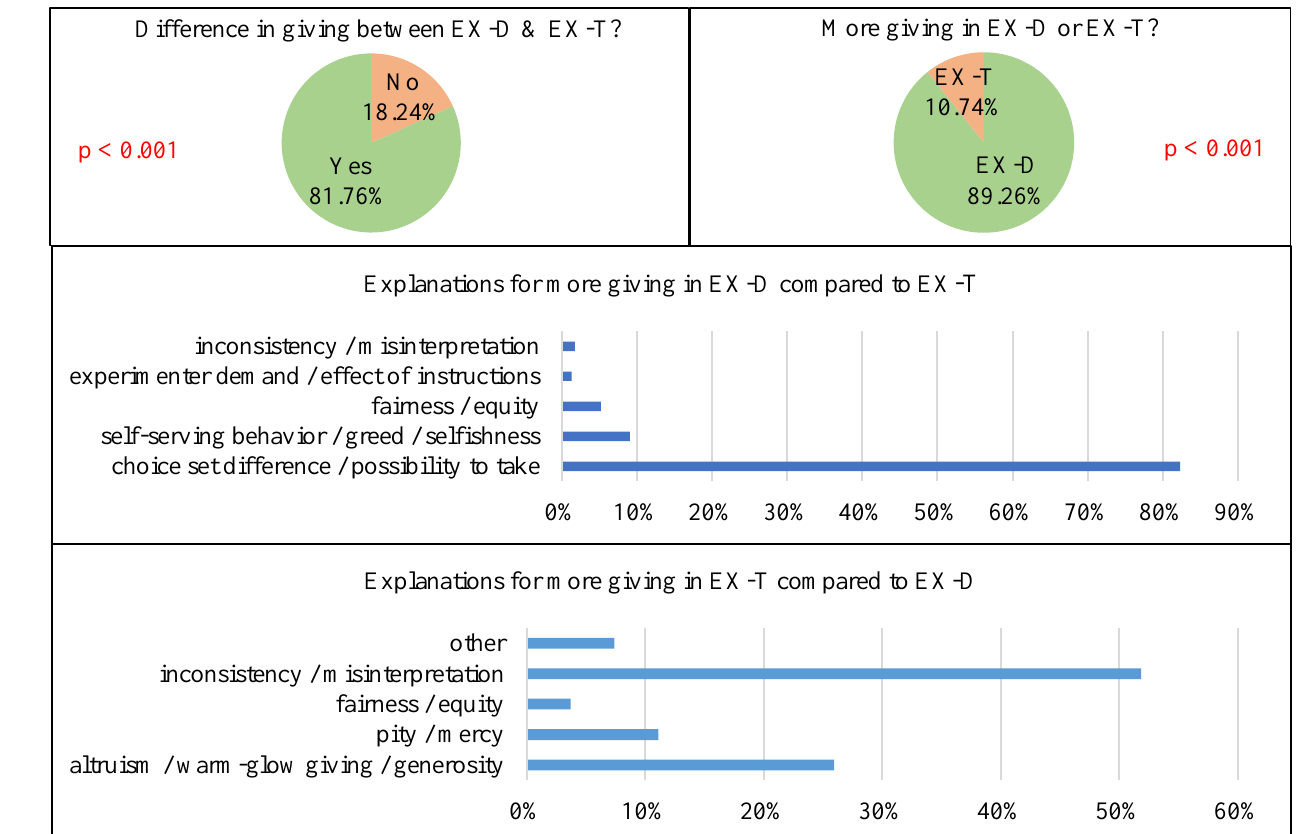
Figure 3. Survey results for Hypothesis 1 (exogenous games).